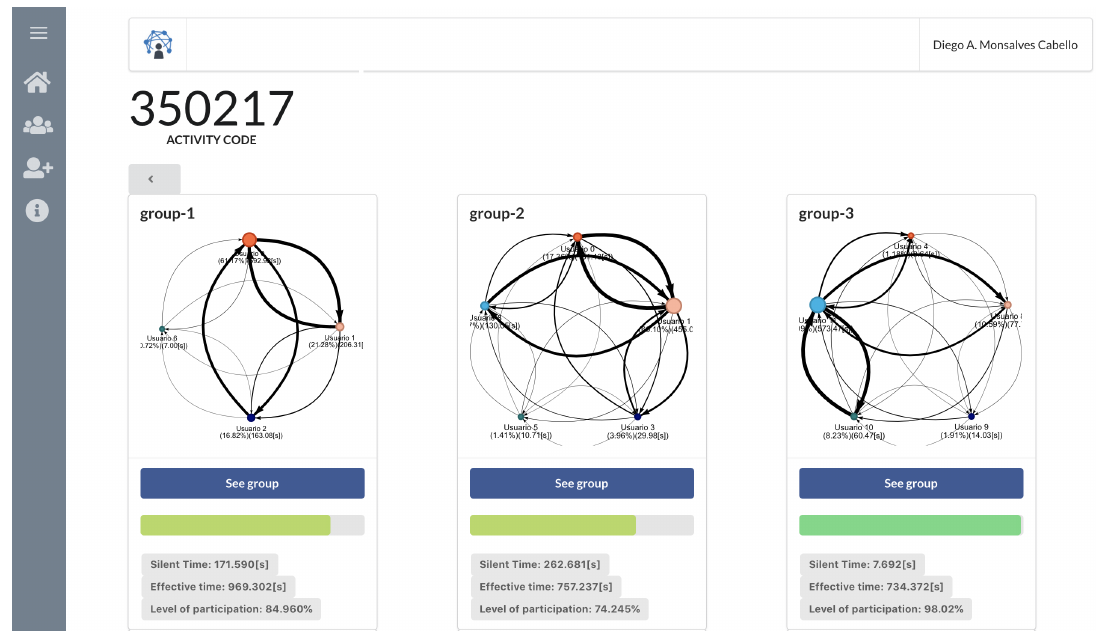
Figure 4. Dashboard view of influence graph and silent time bar for multiple